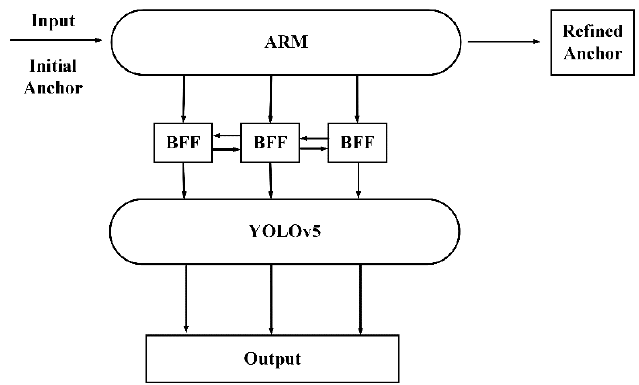
Figure 6. Model structure diagram of YOLOv5+DAFS.